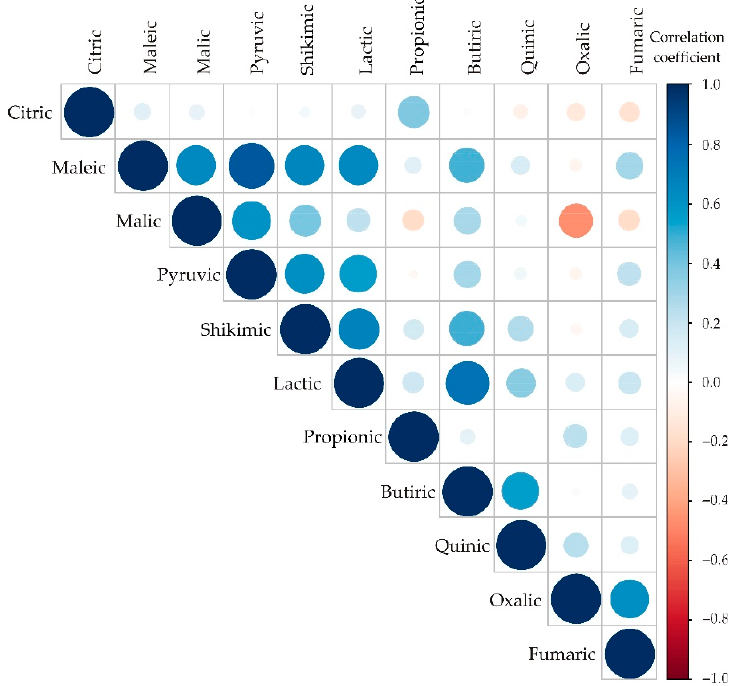
Figure A3. Color correlation graph between fruit acids content in plum samples.